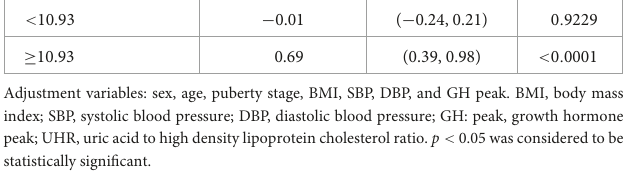
TABLE 3 Independent correlation between UHR and ALT by multivariate piecewise linear regression. Inflection point of UHR (%)